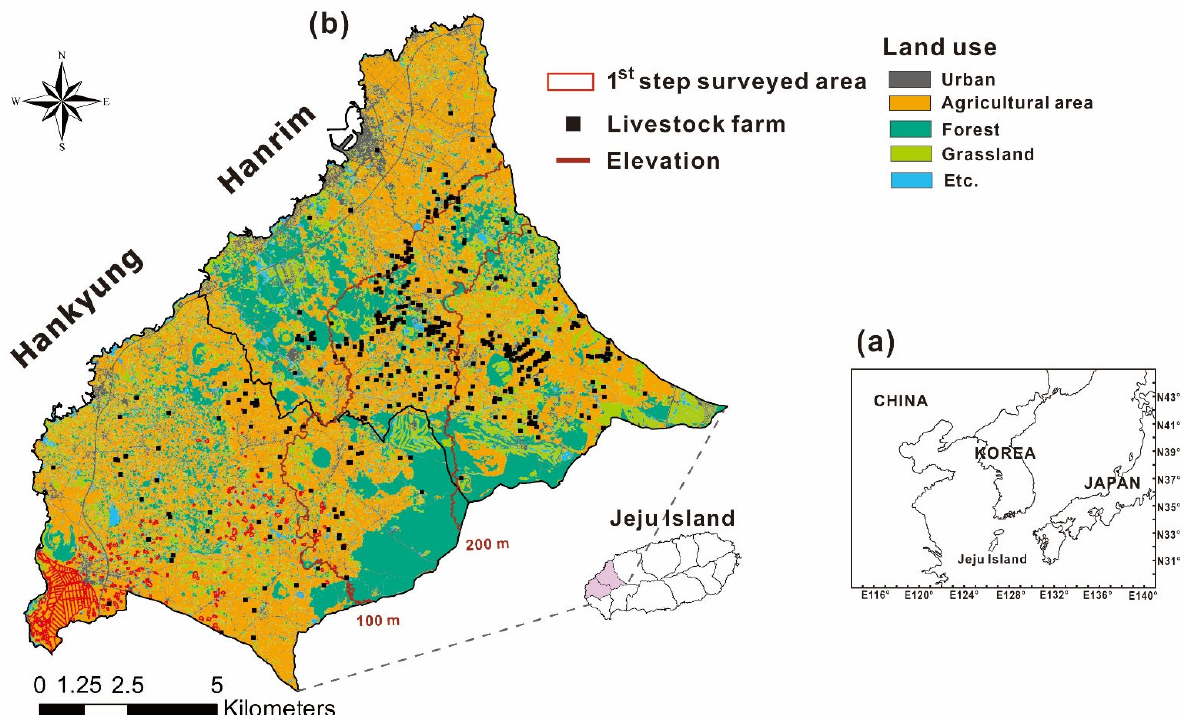
Figure 1. ( a ) Location map of Jeju Island and ( b ) the Hanrim and Hankyung study areas, showing livestock farms and land use (2016).